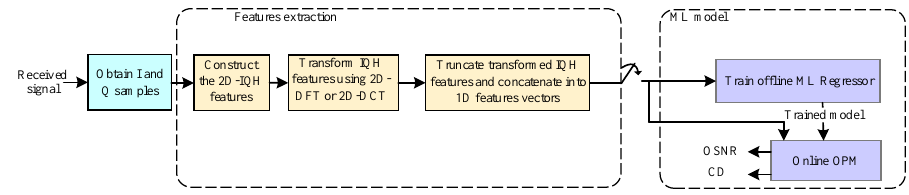
Figure 3. Schematic diagram for our proposed OPM using ML techniques.